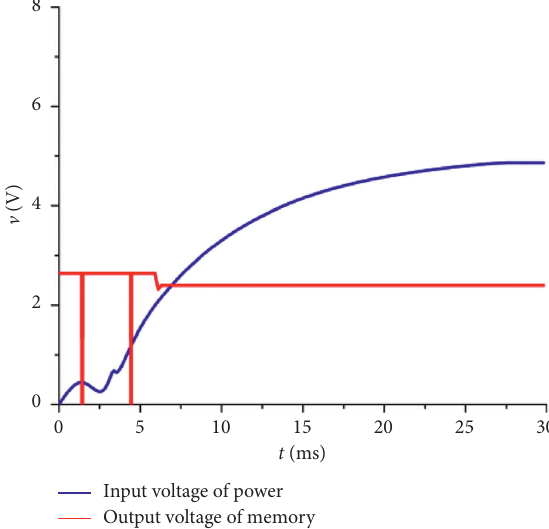
Figure 11: Changes of power input voltage and memory output level.